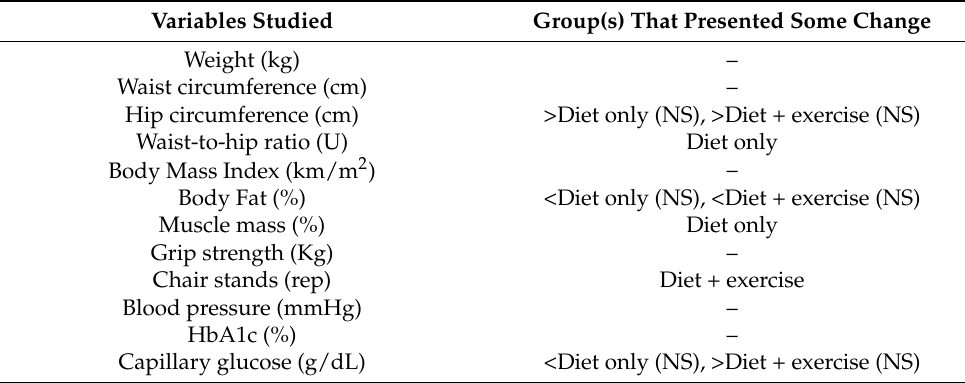
Table 5. Observed trends in the variables